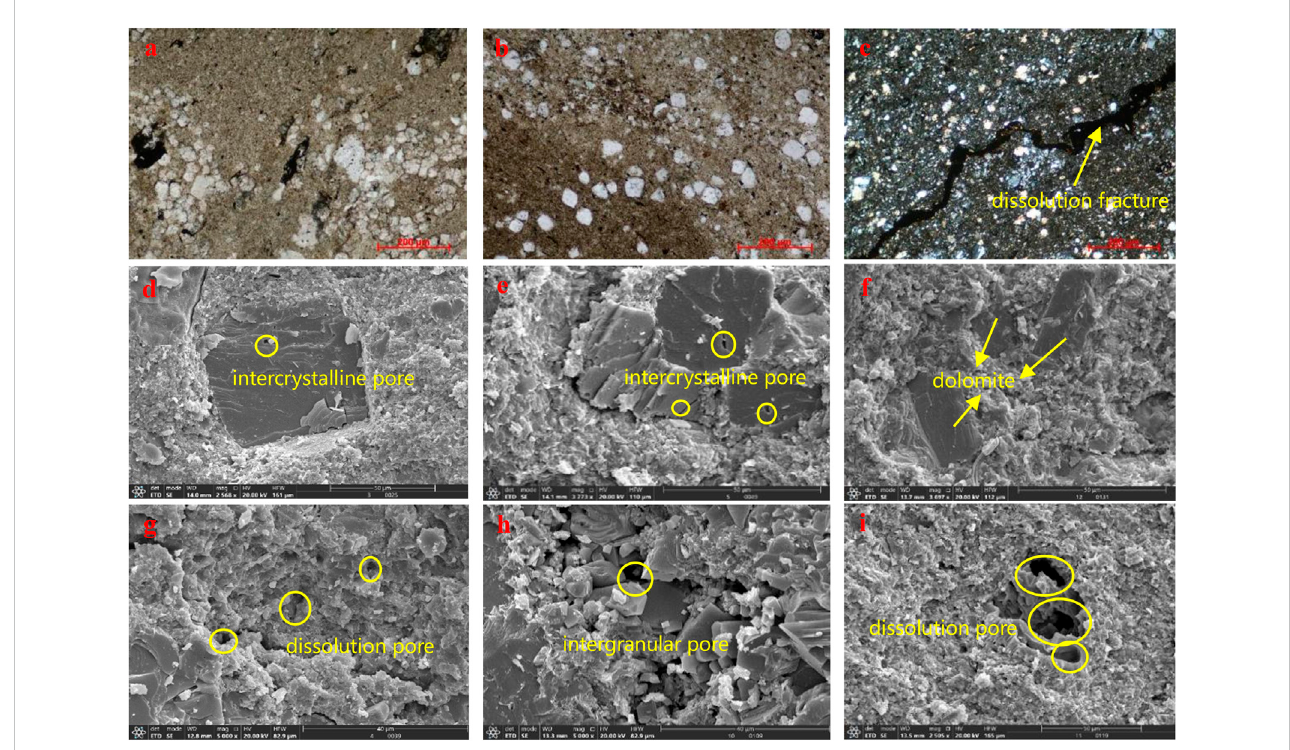
FIGURE 4 Microscopic characteristics of Fengcheng Formation. (A) Dolomite argillaceous anisotropic sandstone with a small amount of organic residues; (B) Dolomite-bearingmudstone,dust-spot-like,silk-likeorganicmatterresidues;fewdissolvedpores; (C) Dolomitesandymudstone,3dissolutionfractures,the fracture width is 0.01 – 0.04 mm; (D) Microcrystalline dolomite, intercrystalline pores (SEM); (E) Intercrystalline pores (SEM); (F) Dolomite and feldspar crystals (SEM); (G) Dissolved pores (SEM); (H) Intercrystalline pores and intergranular pores (SEM); dissolved pores (SEM).